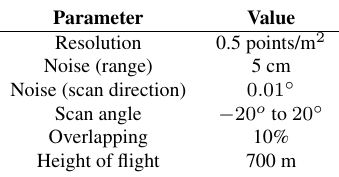
Table 1. Configuration of acquisition simulation.